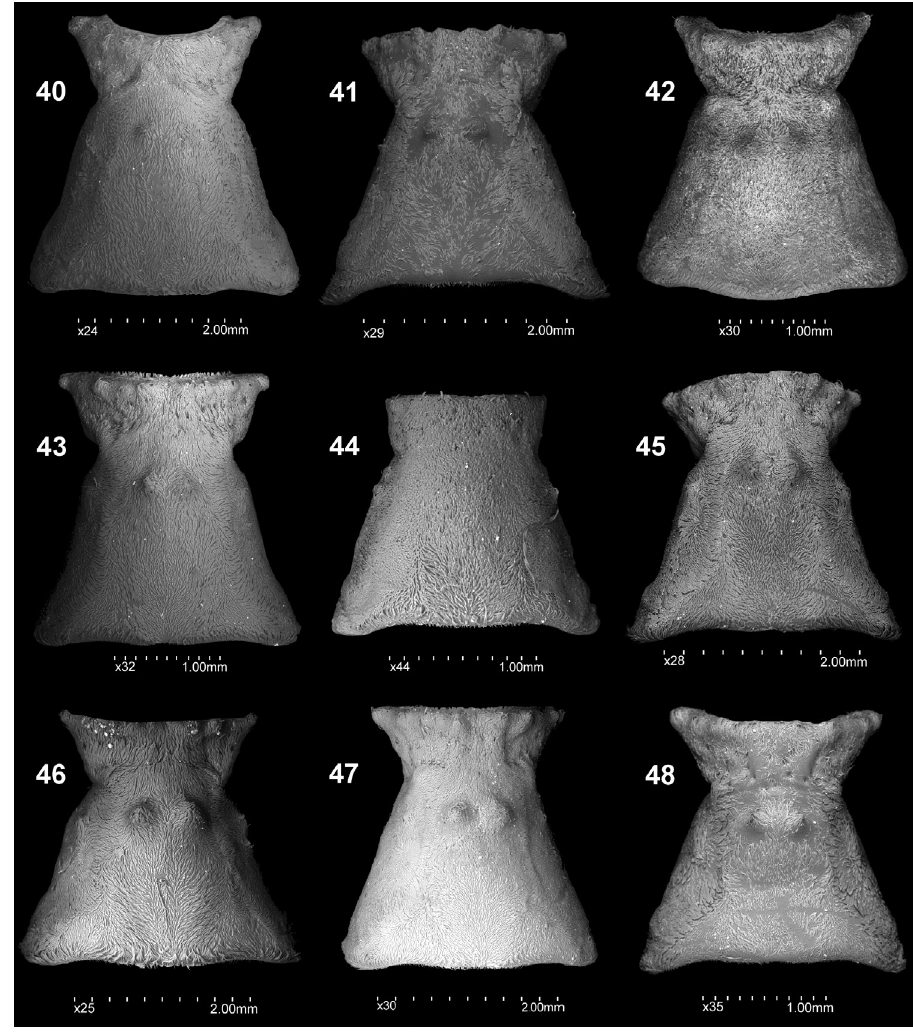
Figures 40–48. Pronotum, dorsal view: 40 C. farinosus Perr. 41 C. fundatus sp. n. 42 C. gibbus sp. n. 43 C. malleus sp. n. 44 C. minimus sp. n.; 45 C. rutai sp. n. 46 – C. szoltysi sp. n. 47 C. torosus sp. n. 48 C. turbidus sp.